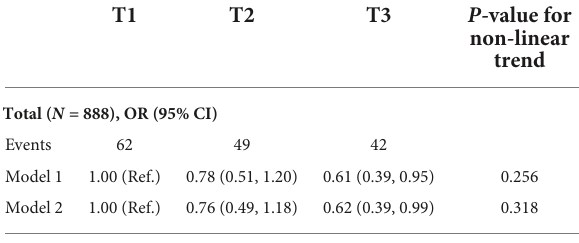
TABLE 3 Association between serum SPD levels and incident MCI.